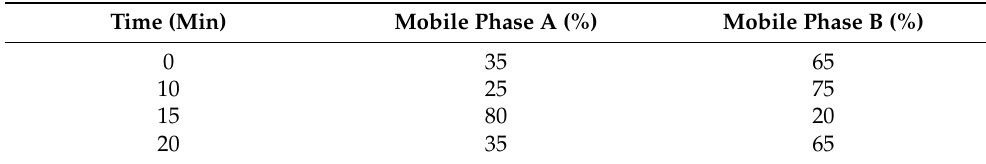
Table 2. HPLC gradient elution program at 0, 10, 15 and 20